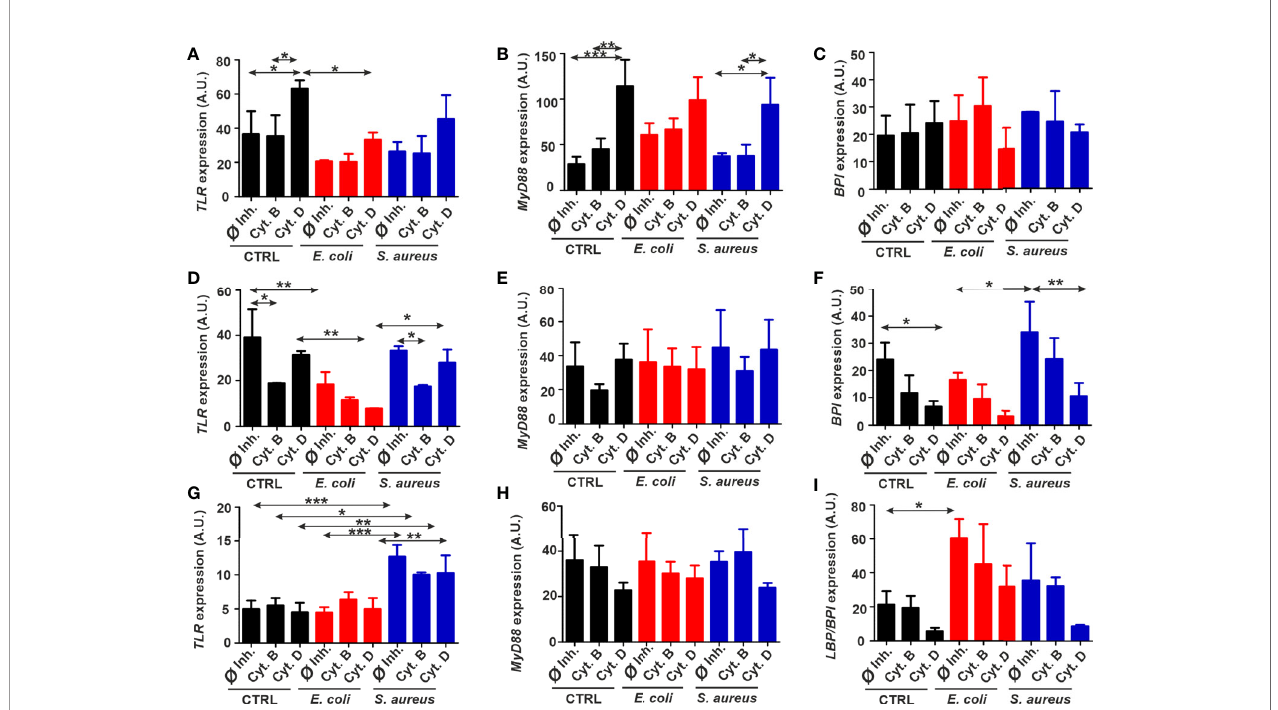
FIGURE 5 | Fluctuations of immune-related gene expressions in target cells exposed to bacteria and phagocytosis inhibitors. Normalized expression of TLR , MyD88 , and BPI in (A – C) THP-1, (D – F) diff. THP-1 and normalized expression of TLR , MyD88 , and LBP / BPI (G – I) in coelomocytes after bacterial challenge in the absence or presence of the uptake inhibitors. The results are presented as mean ± SD of three replicates. Asterisks display statistical signi fi cance (* p < 0.05, ** p < 0.01, *** p < 0.001). The signi fi cance of data was evaluated by one-way ANOVA with Tukey ’ s multiple comparison test. A.U., arbitrary